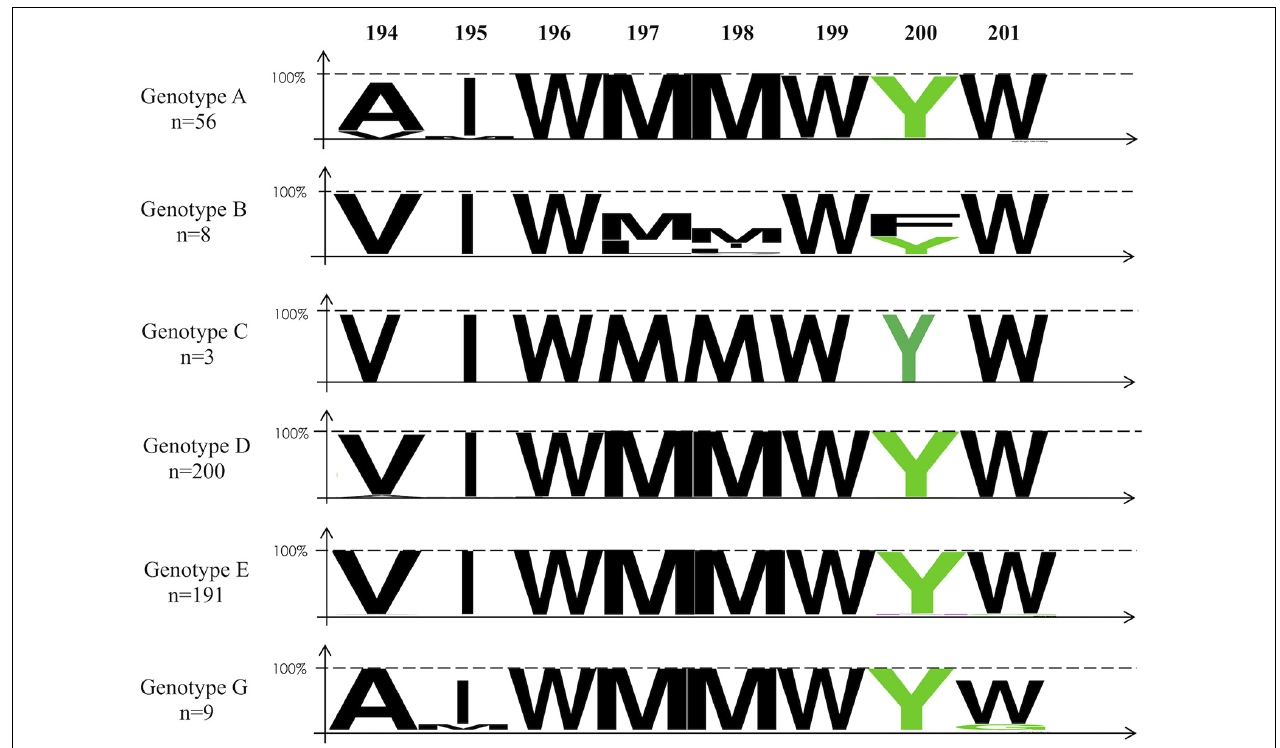
FIGURE 2 | Alignment of the amino-acid sequences of the HDV matrix domain within the cytosolic loop II of the HBV envelope protein using the Web Logo representation according to genotypes. The colors correspond to the physico-chemical properties of the amino acids: polar amino acids G, S, T, Y, and C (green); negatively charged amino acids Q and N (purple); basic amino acids K, R, and H (blue); acidic amino acids D and E (red); and hydrophobic amino acids A, V, L, I, P, W, F, and M (black). On the top of the figure: Amino-acid position. On the left, the number (n) of sequences analyzed for each genotype group. Accession numbers of the sequence of the strains used: AY862864; AB033558; AB033559; AB036920; AB048701; AB059661; AB076678; AB086397; AB104712; AB106564; AB116549; AB194951; AB194952; AB205127; AB222713; AB246335; AB274976; AB298362; AB453987; AB493845; AB493848; ABO56513; ABO56514; AF090839; AF090841; AF090842; AF223965; AF297624; AJ309371; AJ627219; AJ627221; AM180623; AM184125; AM494691; AY090455; AY090461; AY161140; AY179734; AY233288; AY236164; AY311369; AY796031; AY934767; D00329; D00331; D00630; D12980; D16665; D23677; DQ315776; DQ315779; DQ336679; EF103278; EU239220; EU366129; FJ692532; FJ692554; FJ692556; FJ692561; FJ692597; FJ904405; FJ904442; FM199974; FN594769; FN594771; GQ331046; GQ331048; GU456648; X65257; X85254; Z35716; AJ131574; and